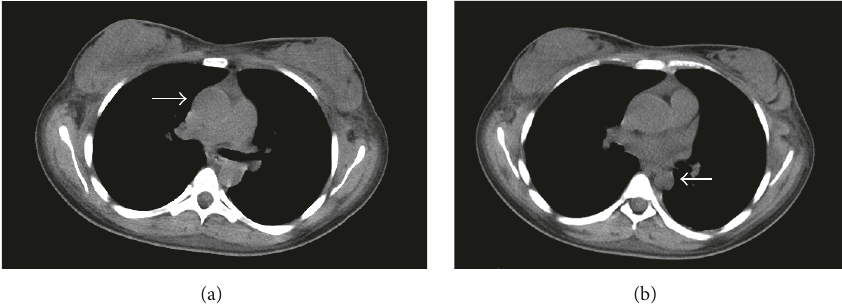
Figure 1: Noncontrast CT of the chest demonstrated (a) ectasia of the ascending aorta, measuring 3.4 cm, and (b) focal narrowing of the descending aorta, measuring 1.7 cm, raising concern for an aortitis in the setting of glomerulonephritis. The white arrow in (a) represents the ascending thoracic aorta and in (b) the descending thoracic